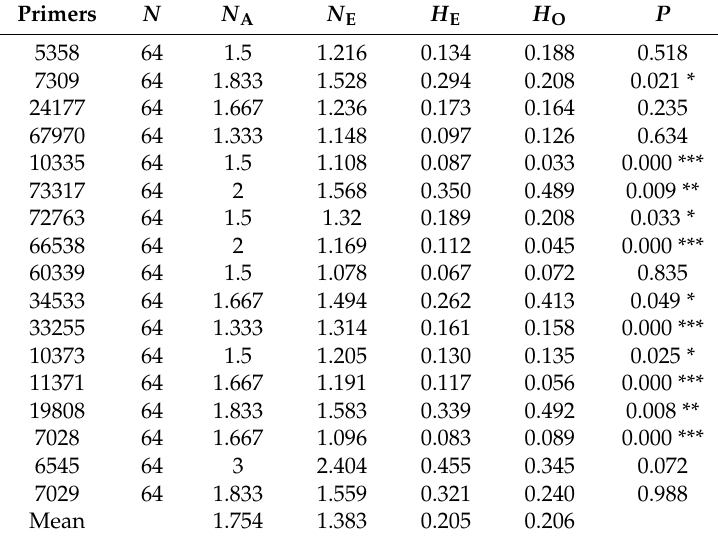
Table 3. The parameters of genetic diversity of the 17 expressed sequence tag-simple sequence repeats (EST-SSR) primers of P. bungeana .